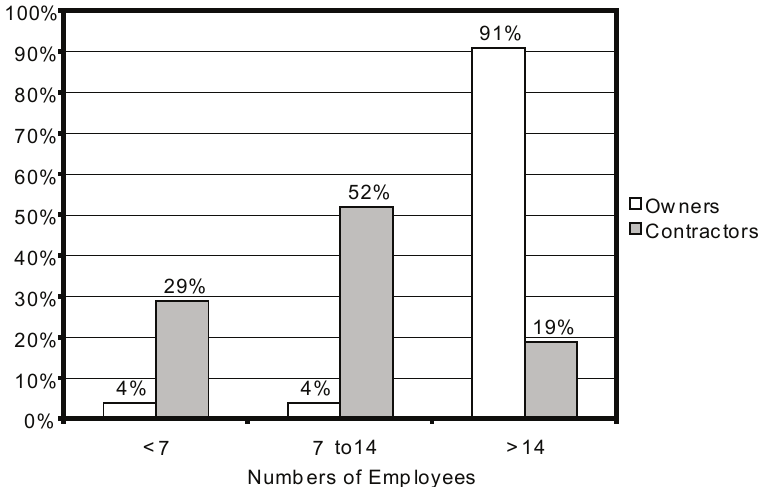
Figure 1: Distribution of respondents by number of employees